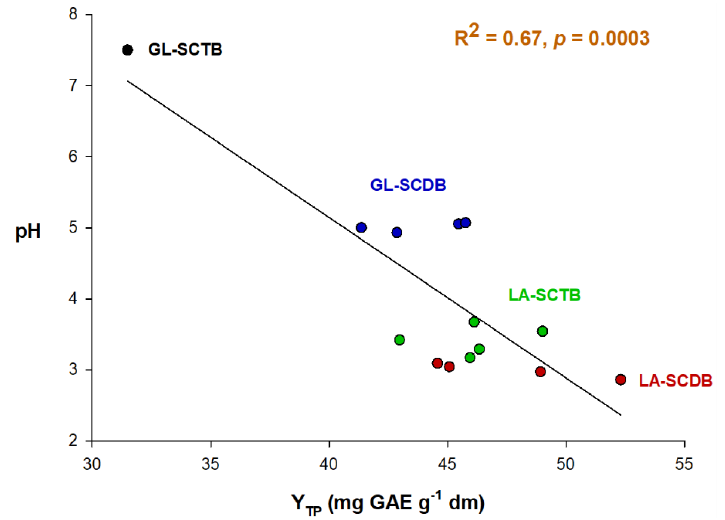
Figure 3. Linear regression between the pH of the DES tested and Y TP . All DES were tested as 70% ( w / v ) aqueous mixtures.